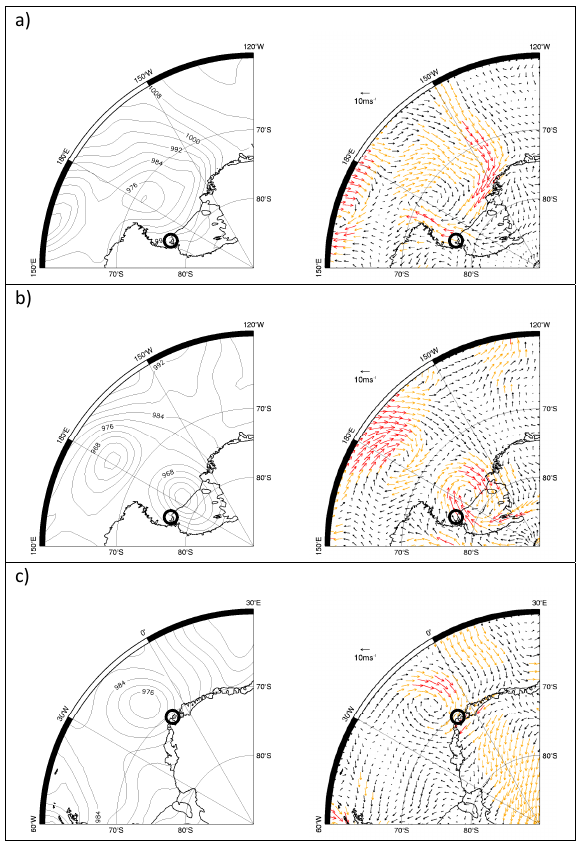
Fig. 18. Charts of mean sea level pressure and 10-m wind vec- tors coincident with high altitude ODEs discussed in earlier papers (see text for full discussion); (a) Arrival Heights: 23 August 1995 (18:00); (b) Arrival Heights: 14 September 1995 (12:00); (c) Neu- mayer: 1 August 1995 (12:00). The positions of the stations are marked by the black circles on the plots. Wind speeds are identified as: black = < 8ms − 1 ; orange = 8 to 12ms − 1 ; red = > 12ms − 1